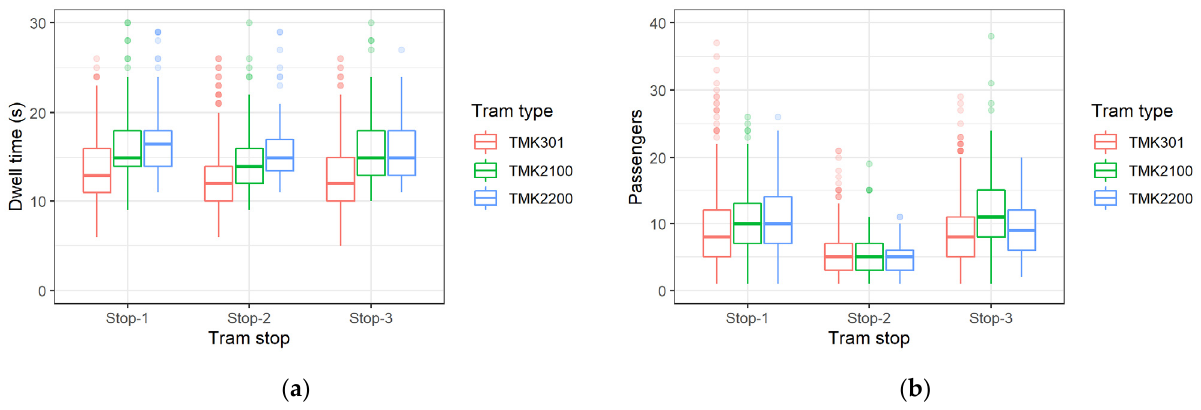
Figure 10. Distribution according to tram vehicle type and tram stop: ( a ) dwell time; ( b ) passenger volume.